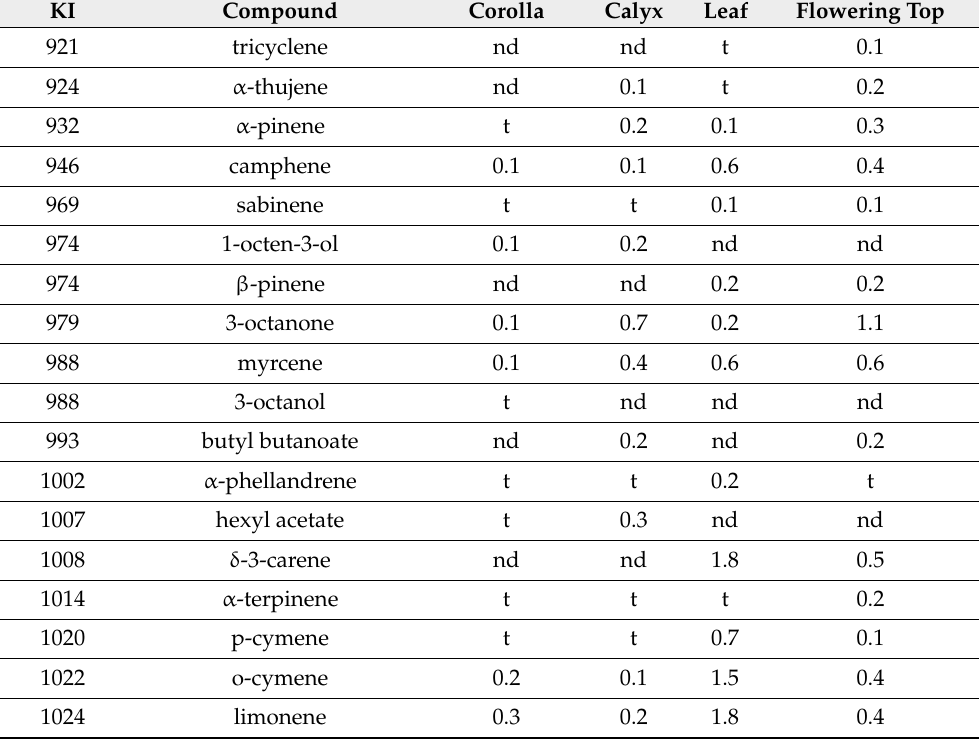
Figure 1. Portions of Lavandula angustifolia used: ( A ) corolla, ( B ) calyx, ( C ) leaf, ( D ) flowering top. Table 1. Aromatic profile of L. angustifolia essential oil from the corolla, calyx, leaf, and whole flowering top. Each reported value below represents the average of three essential oil samples distilled from each portion. Each essential oil sample was analyzed in triplicate. Values less than 0.1% are denoted as trace (t) and those not detected in a portion of the plant as not detectable (nd). Unidentified compounds less than 0.5% are not included. KI is the Kovat’s Index value obtained using a linear calculation on DB-5 column [38]. Relative area percent was determined by GC-FID. KI Compound Corolla Calyx Leaf Flowering Top 921 tricyclene nd t 0.1